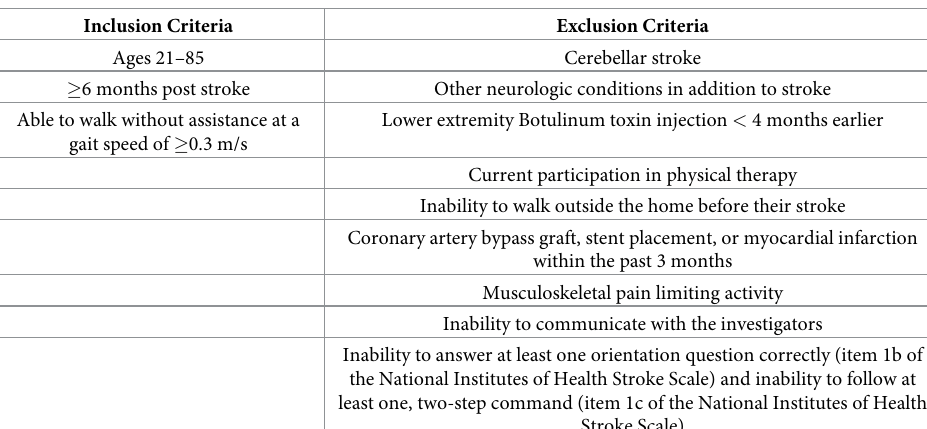
Table 1. Eligibility criteria